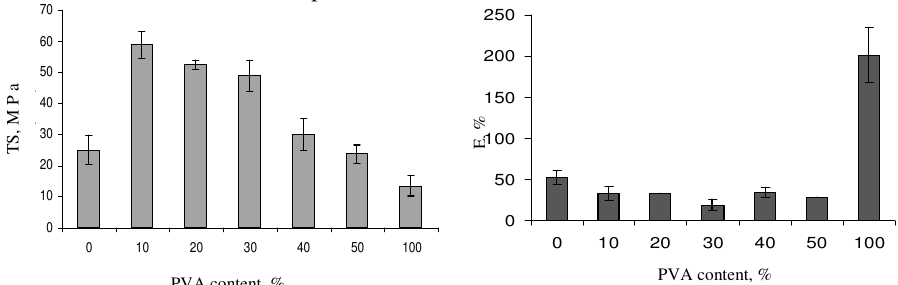
Figure 1. Tensile strength of chitosan/PVA blended films